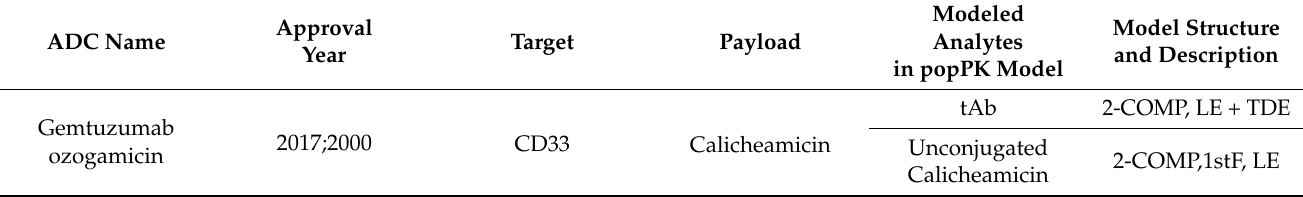
Table 1. Modeling approaches of approved ADCs in clinical